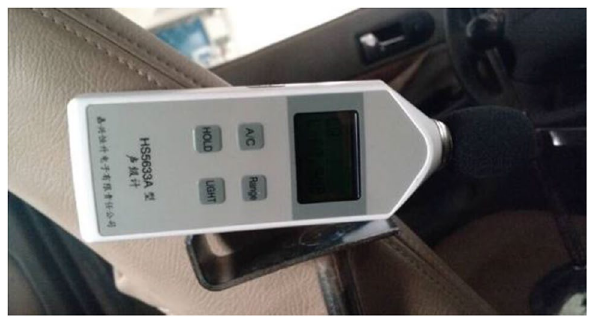
Fig. 4 Placement of sound level meter in car test